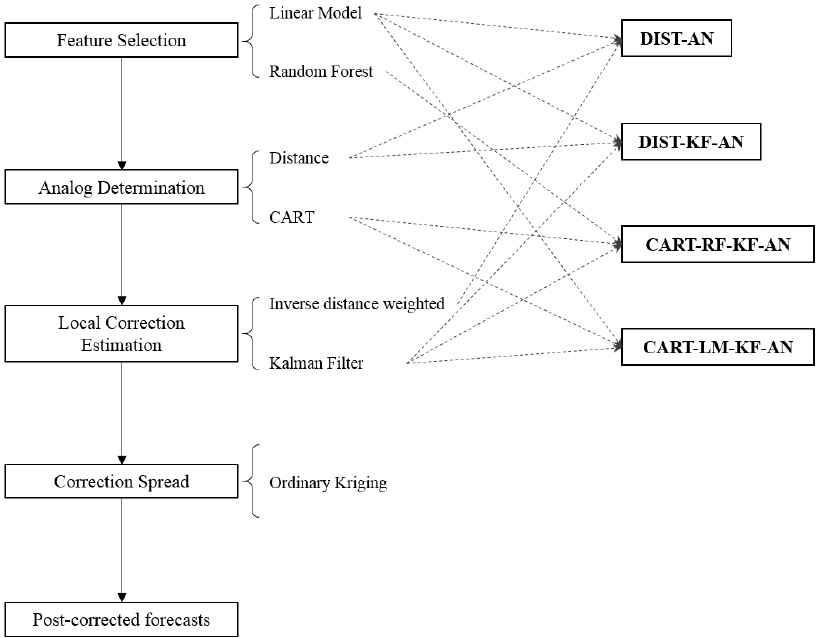
Figure 2. Bias-correction framework with its four steps and the four method combinations that are tested in this study. The fifth method tested is the 7-day Moving Average (7-Day-MA) method, which can be regarded as a special case within the framework but is not explicitly shown